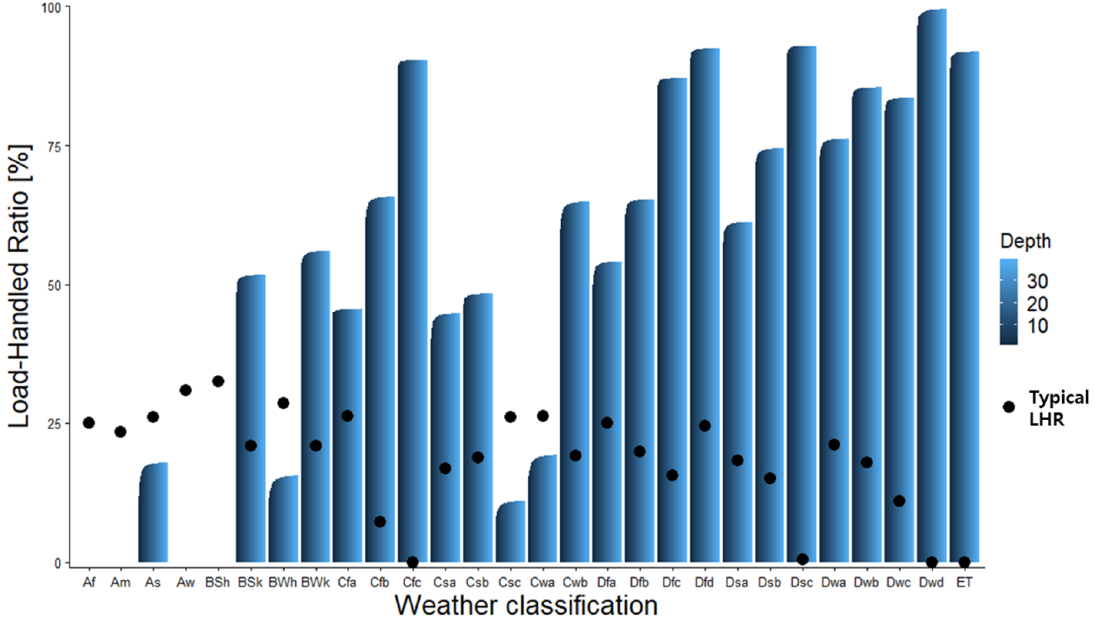
Figure 11. Comparison of typical LHR and application of ground calculation in simulation.